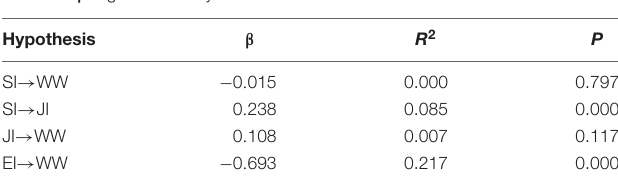
TABLE 6 | Regression analysis.